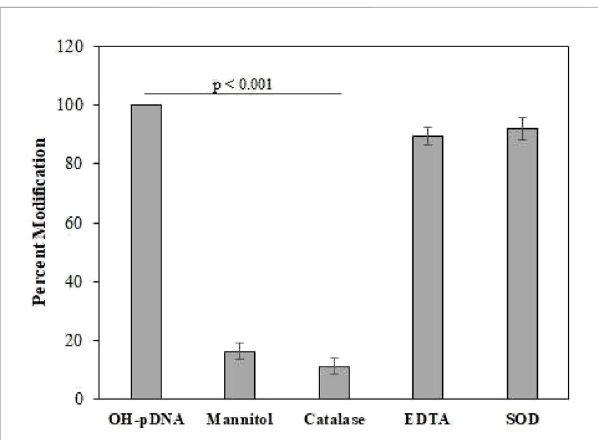
The OH-pDNA was considered as 100% modi fi cation based on the UV analysis at 260 nm. Quenching studies were performed using catalase (500 units/mL), mannitol (100 mM), EDTA (100 mM) and SOD (500 units/mL). Antioxidant were co-incubated with the reaction during modi fi cation of the pDNA and samples were analysed at 260 nm. All the reactions were carried out in triplicates. Signi fi cance presented as p <